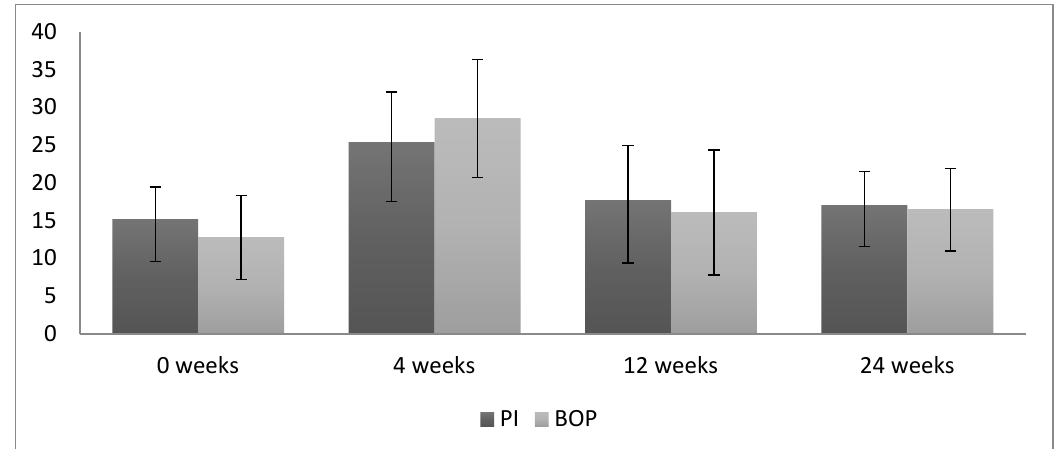
Figure 2. Plaque index (PI) and bleeding on probing (BOP) percentage (%) observations from baseline to 24-week follow-up among patients treated with lumineers.